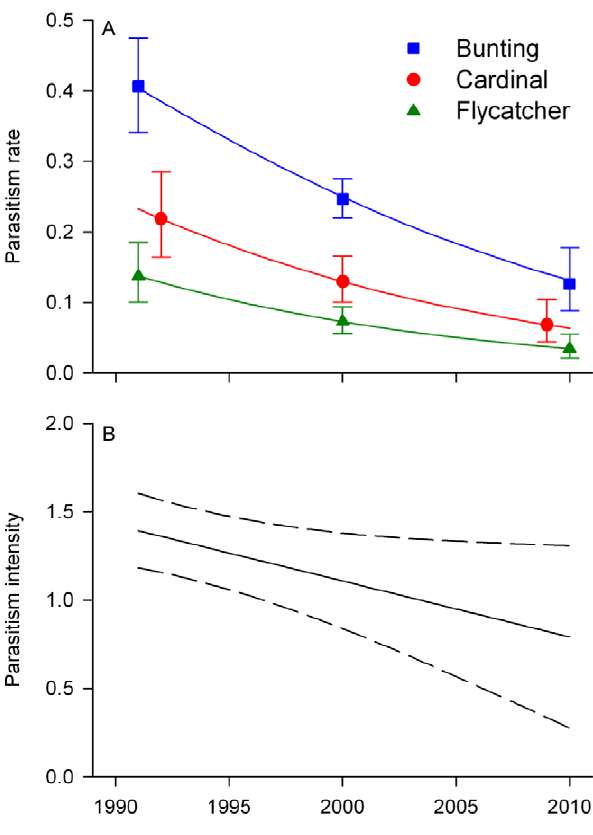
Figure 3. Temporal trends in parasitism rates and intensity. Model-based predictions of Brown-headed Cowbird parasitism rates (A) and intensity (B) for three songbird species in Missouri, USA, 1991–2010. Rates are for a population at the median value for forest cover (53%) and at observed frequencies of nests in three habitat types (forest, clearcut, non-forest). Rates in (B) are for a balanced population of the three songbird species. Intensity values , 1 are not possible (i.e., there cannot be , 1 cowbird egg or nestling in a parasitized nest), so predictions of parasitism intensity should be interpreted with regard to temporal changes rather than absolute values. Error bars in (A) and dashed lines in (B) represent 95% confidence intervals, with some bars offset for visual